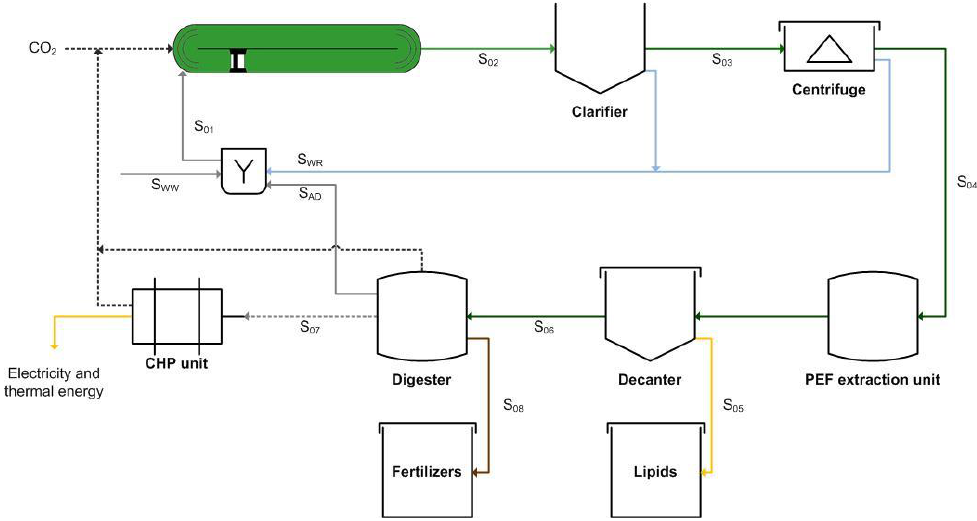
Figure 2. Process diagram. CHP—combined heat and power; PEF—pulsed electric field.